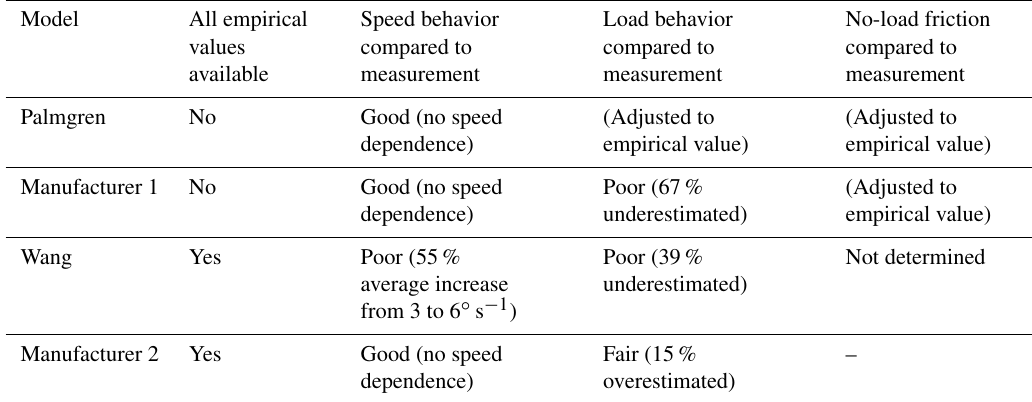
No-load friction compared to measurement (Adjusted to empirical value) (Adjusted to empirical value) Not determined